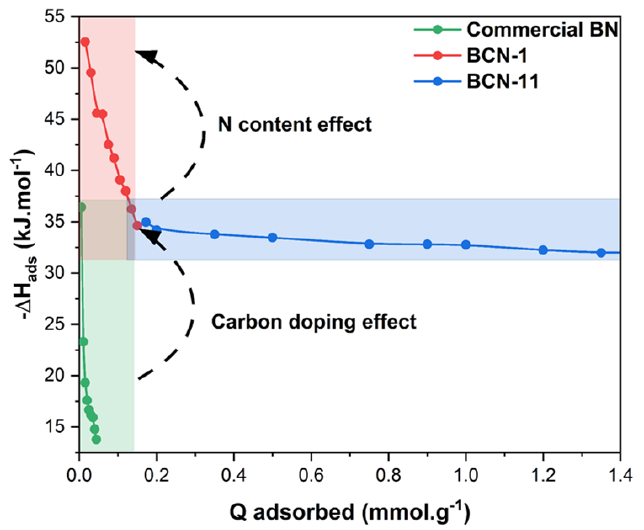
Figure 7. Isosteric adsorption enthalpies of Commercial BN, BCN − 1 and BCN − 11 as a function of CO 2 adsorbed quantity.